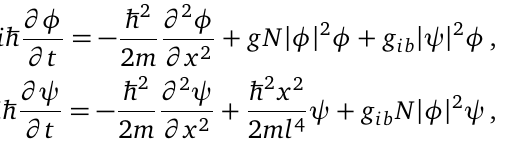
(cid:128) (cid:138) ml 2 . Numerical ħ h (cid:0) ħ h (cid:1) = g . The density , and g ib ml